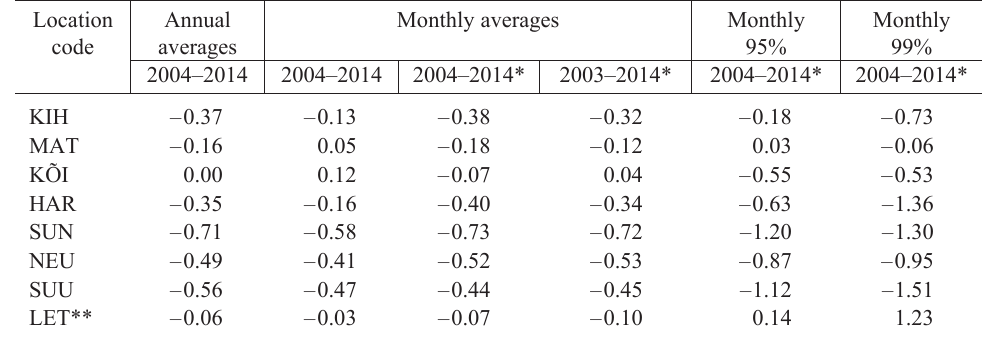
Table 3. Trends (cm year –1 ) in monthly data of averages (different versions), 95th and 99th